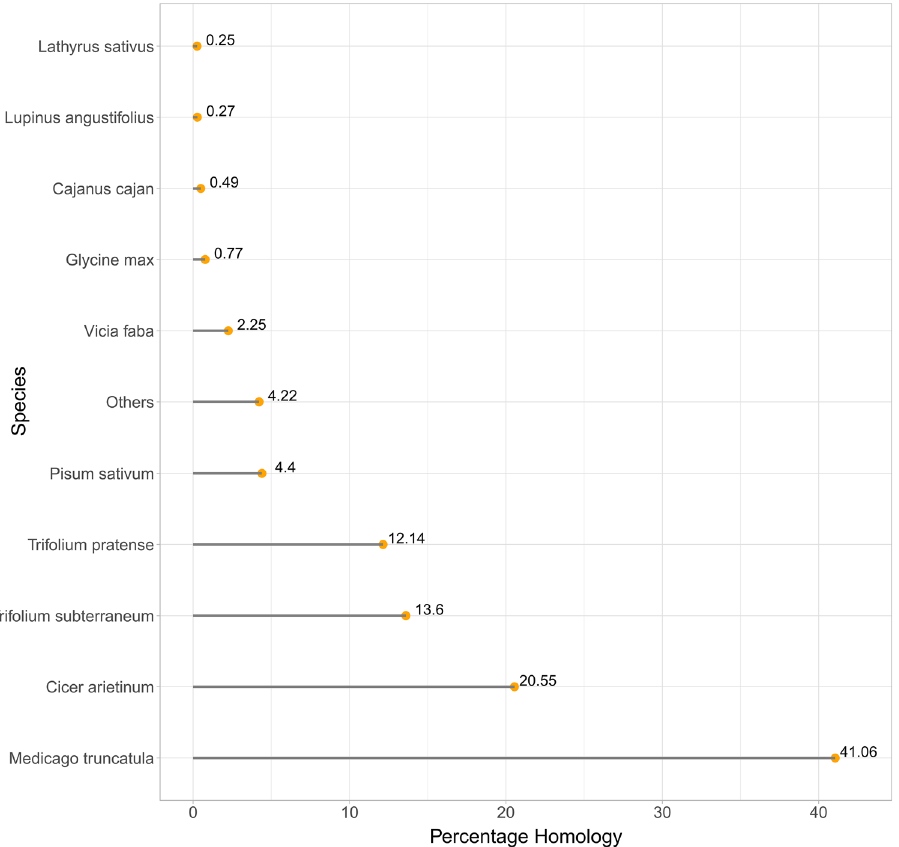
Figure 2. Basic local alignment search tool (BLAST) top-hit species distribution. The substantial similarity to sequences from Medicago truncatula and Cicer arietinum may reflect a close phylogenetic